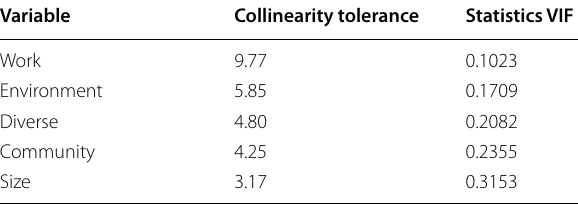
The dependent variables for the test are ROA, ROE and